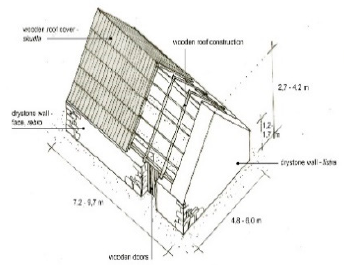
Figure 26. Basic aspects of glada, sketch: A. Kapetanovi ć .